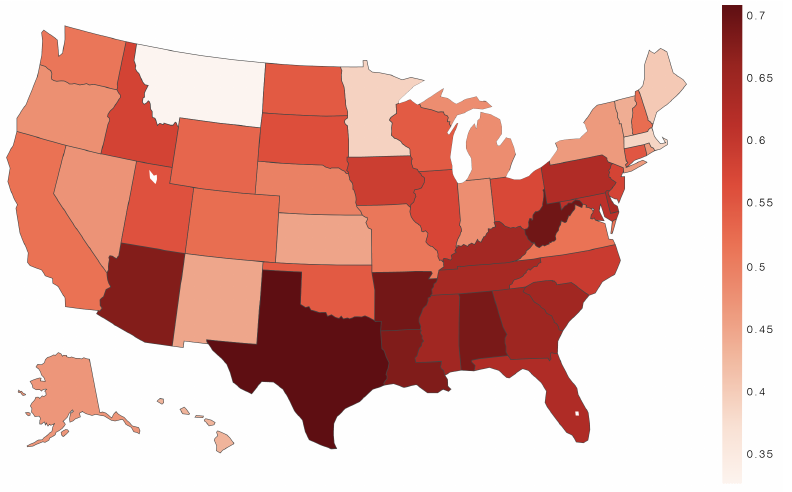
Figure 1. Anti-science ratio per state. The anti-science ratio measures the share of anti-science users among all Twitter users from a county who are posting anti-science or pro-science content. States aggregate statistics of their constituent